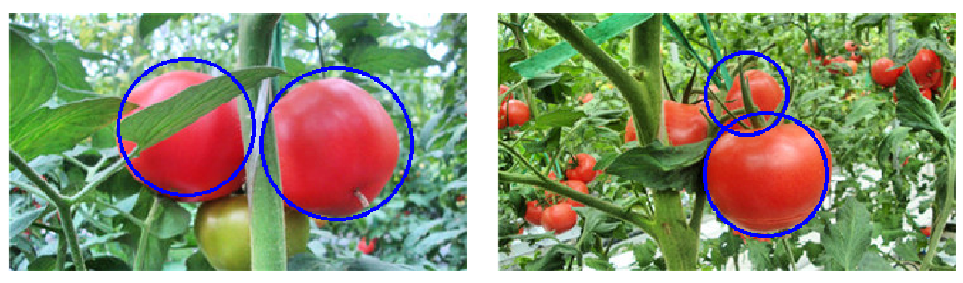
Figure 16. The detection results under different conditions: ( a ) the overlapped conditions and ( b ) the occlusion conditions.